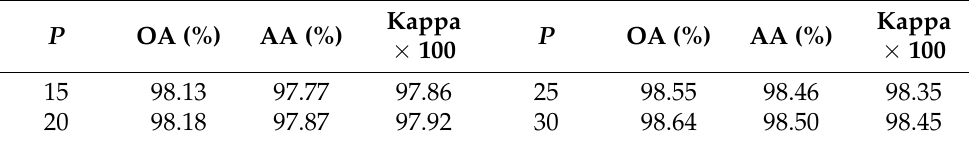
Table 5. In the IP dataset, impact of the number of retained principal component on the